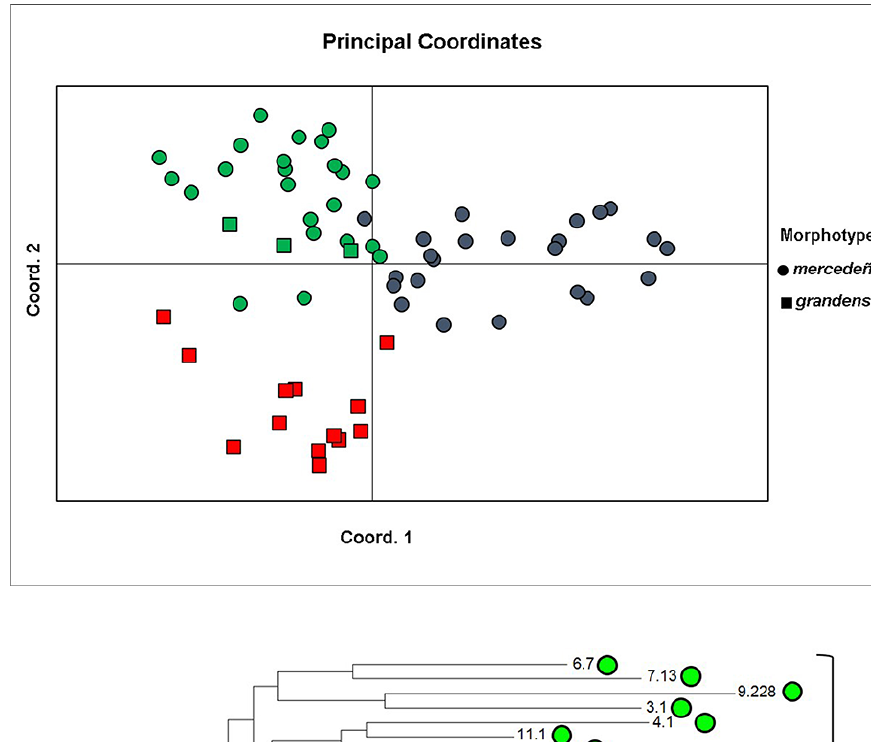
Figure 7. Neighbor- Joining tree constructed with RAPD markers based on Nei and Dice´s genetic distances between individuals from Turnera sidoides subsp. carnea . Dark and grey circles represent individuals assigned to the grandense and the mercedeño morphotypes, respectively. Numbers refer to population and individual`s ID.